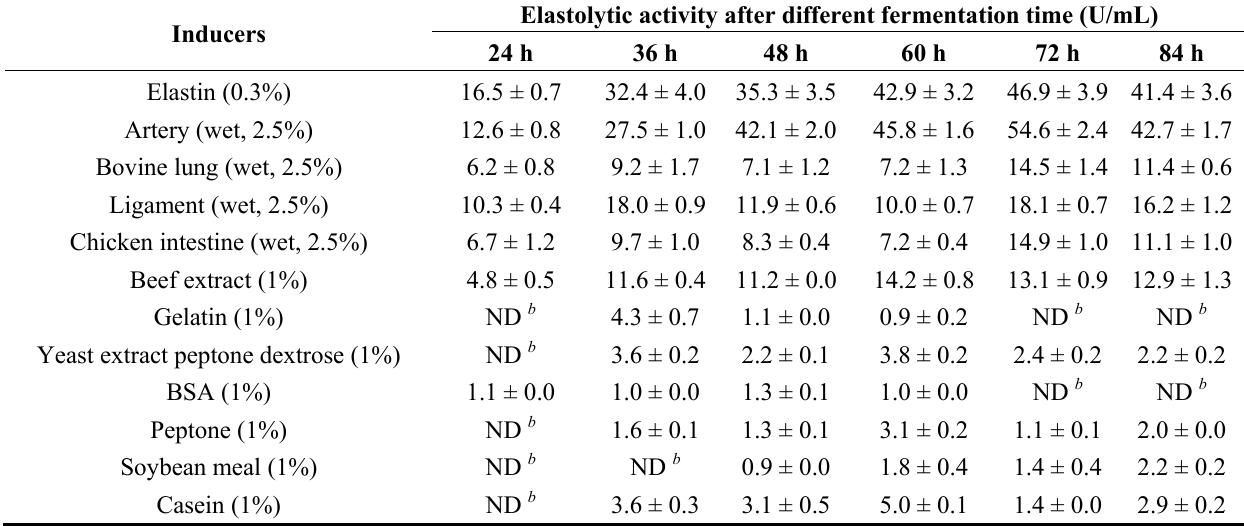
Table 1. Effects of various inducers on pseudoalterin production of CF6-2 a .